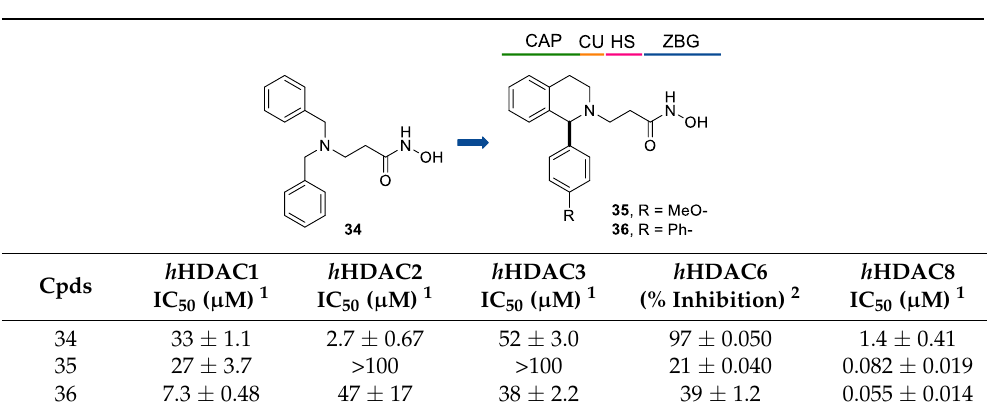
Table 6. General structure and IC 50 values of 34 , 35 , 36 [145].